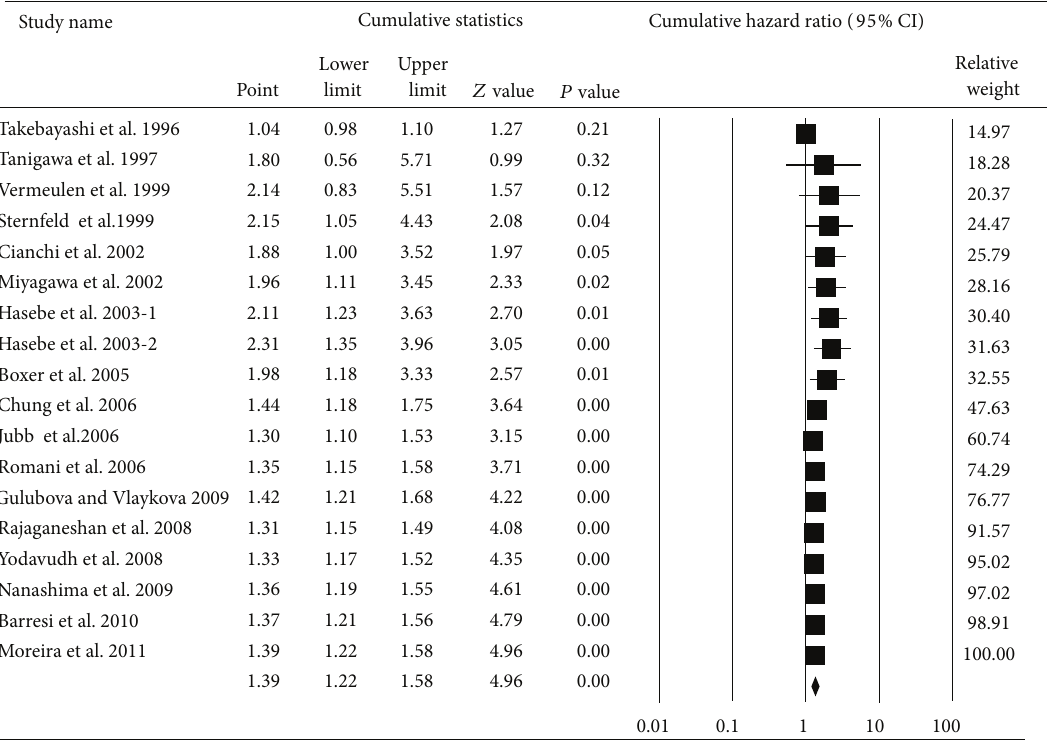
Cumulative hazard ratio ( 95 % CI) P value Z value